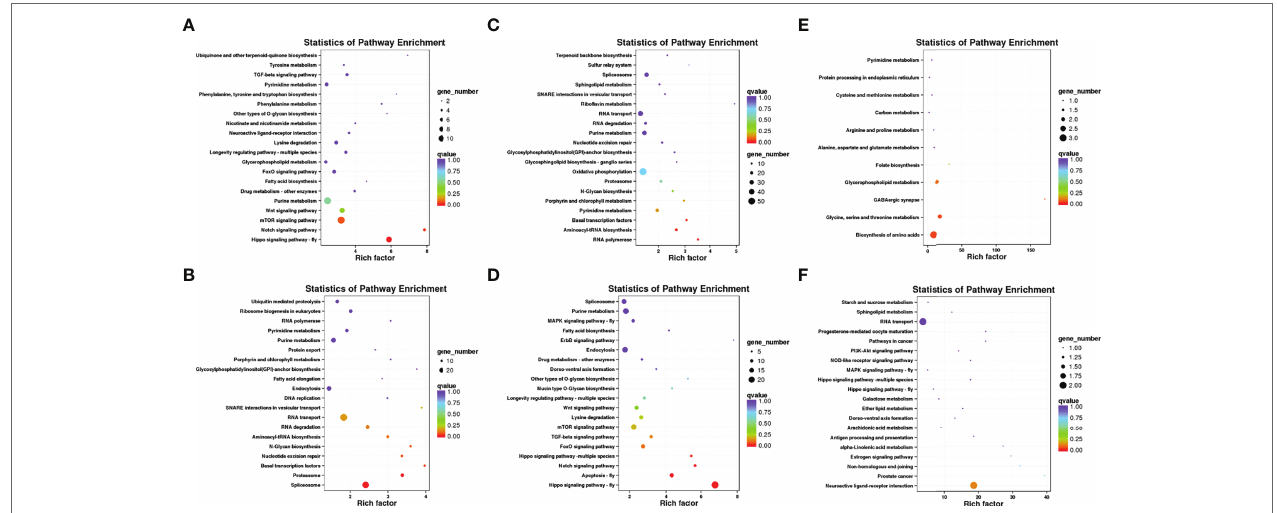
FIGURE 5 | The enrichment analysis of KEGG pathways of DEGs of C. japonica exposed to three salinity gradients. (A) compared with the salinity of 15‰, the KEGG pathways of up-expressed unigenes of C. japonica at the salinity of 35‰ and (B) compared with the salinity of 15‰, the KEGG pathways of down- expressed unigenes of C. japonica at the salinity of 35‰; (C) compared with the salinity of 25‰, the KEGG pathways of up-expressed unigenes of C. japonica at the salinity of 15‰; (D) compared with the salinity of 25‰, the KEGG pathways of down-expressed unigenes of C. japonica at the salinity of 15‰; (E) compared with the salinity of 25‰, the KEGG pathways of up-expressed unigenes of C. japonica at the salinity of 35‰; (F) compared with the salinity of 25‰, the KEGG pathways of down-expressed unigenes of C. japonica at the salinity of 35‰.